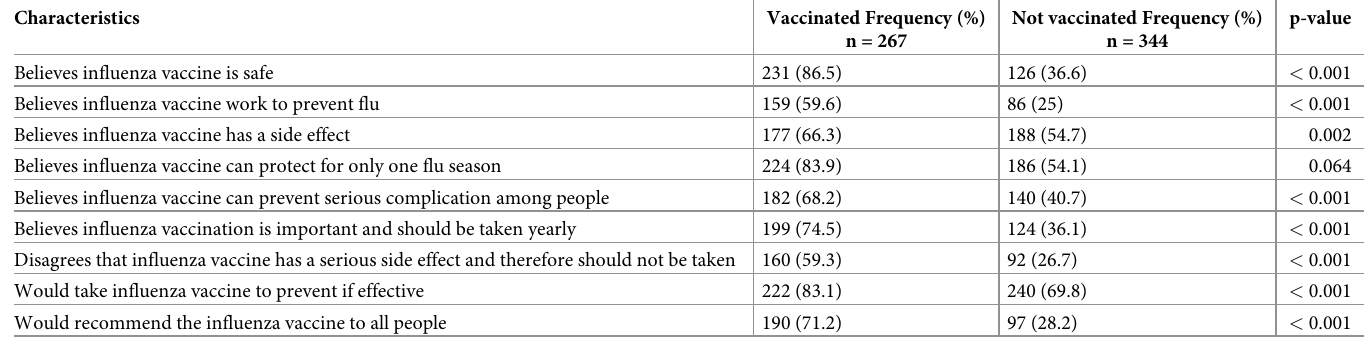
Table 8. Knowledge and attitudes pertaining to influenza vaccination history (N = 611).